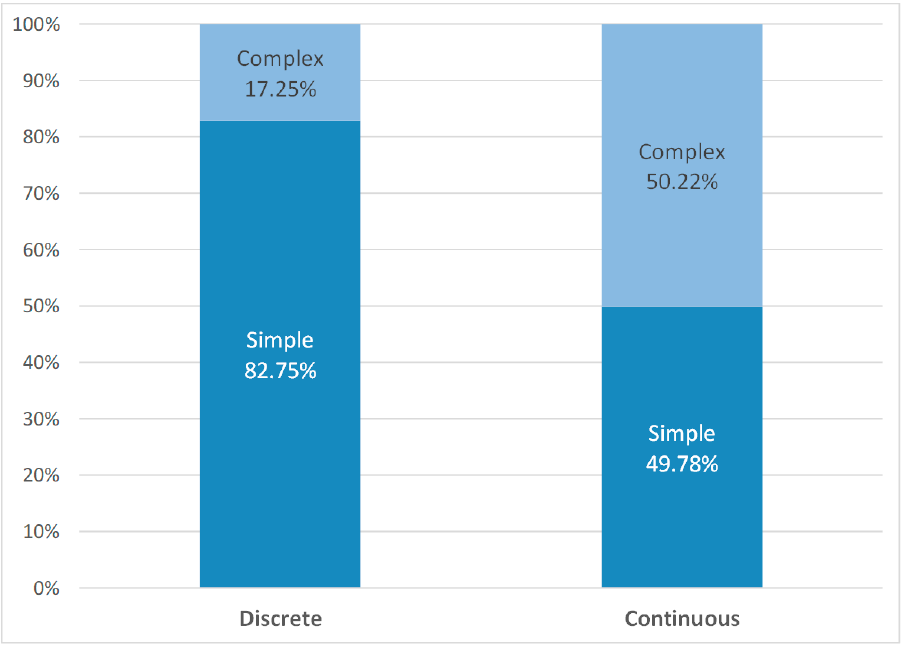
Figure 4. Frequency distribution of complexity of gestures in each category. Simple gestures were highly preferred for discrete tasks.